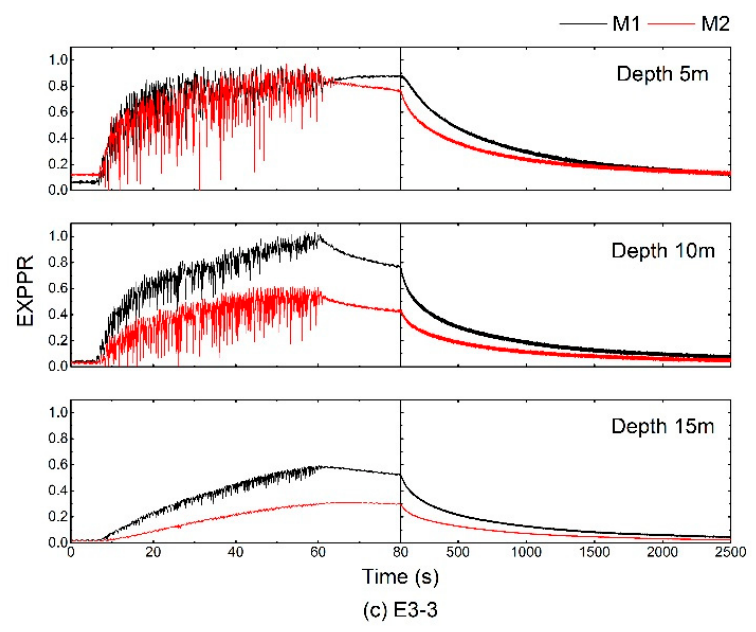
Figure 8. Time histories of excess pore pressure ratio at different depths during different input motions: ( a ) E1 − 3; ( b ) E2 − 3; ( c ) E3 − 3.